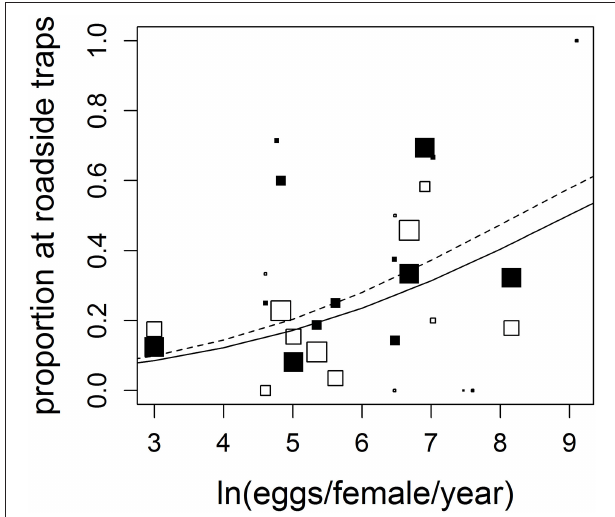
FIGURE 2 | Anuran species with higher reproductive rates were significantly more likely to be found in roadside traps. The black points represent species from the western section (solid line shows predicted model values) while the white points are from the eastern section (dashed line). Each point within each model represents one species. Species represented by smaller data points received lower weight in calculating model parameters because of lower sample size (see Section Materials and Methods). For full species names and sources for eggs/female/yr values, see Supplementary Material.